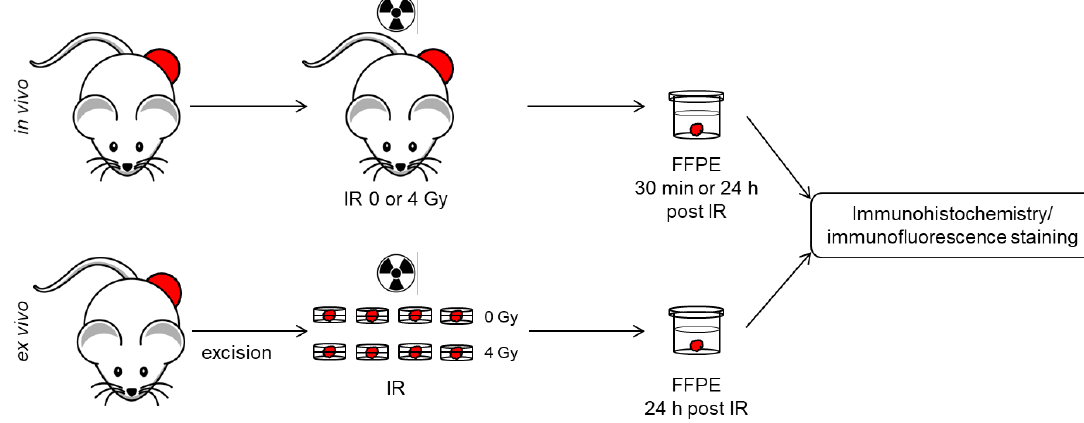
Figure 5. Overview of experimental designs applied in the published datasets of the in vivo [14] and ex vivo (5] cohort. For the in vivo set-up, tumor-bearing mice were exposed to X-ray irradiation (IR). Tumors were excised, fixed in formalin, and embedded in paraffin (FFPE) 30 min or 24 h post IR ( upper panel ). For the ex vivo set-up, tumor specimen were excised, cultured in petri-dished containing medium, and irradiated. Specimens were fixed and embedded 24 h post IR ( lower panel ).